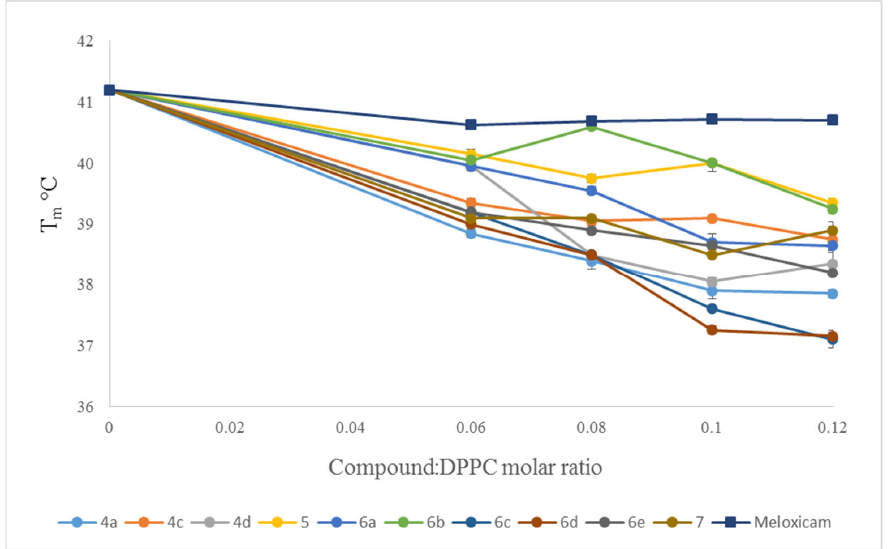
Figure 5. Influence of meloxicam and the 1,2 ‐ thiazine derivatives on the DPPC main phase transition temperature (T m ). Bars represent standard deviations of four measurements; where no error bars are shown, they were smaller than the symbols representing results.